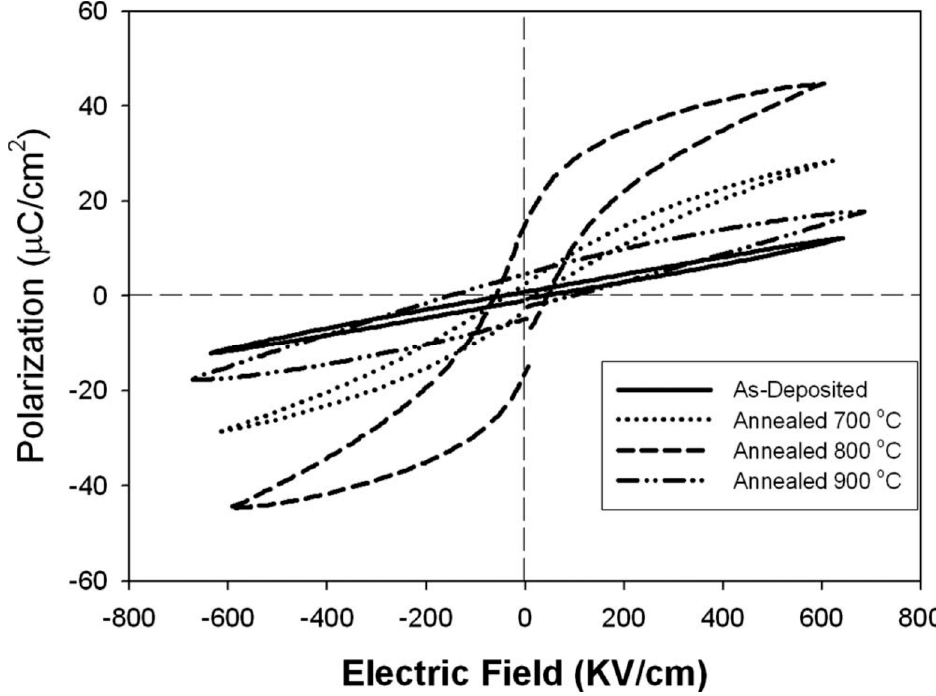
Figure 16. P - E hysteresis loop of the as-deposited and annealed KNN–LSO films [33]. © Copyright 2008, Appl. Phys. Lett. 2008, Appl. Phys.